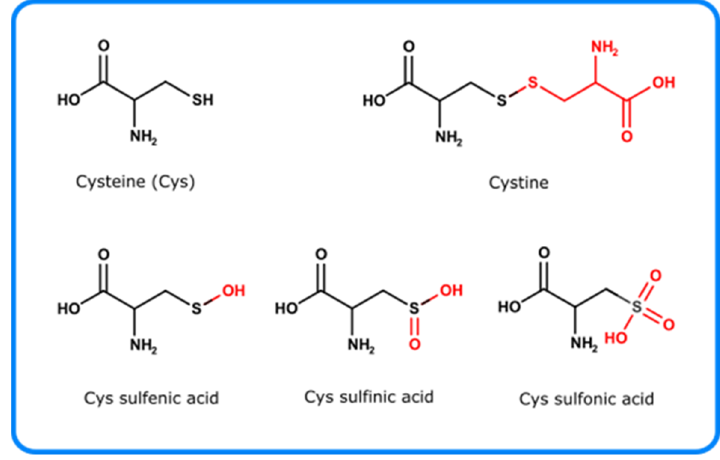
Figure 5. Chemical structures of Cysteine and common Cysteine photo-oxidation products such as Cystine, Cys sulfenic acid, Cys sulfinic acid and Cys sulfonic acid. Table 9. Analytical techniques/assays to detect Cys oxidation products with the corresponding analytical techniques and relevant references.